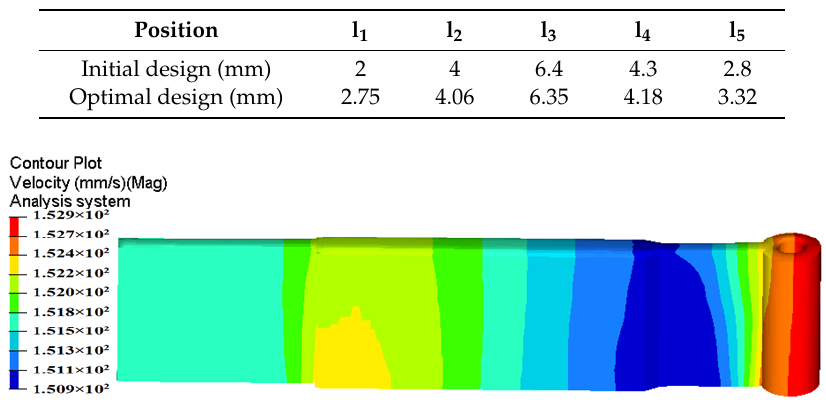
Figure 14. Uneven bearing lengths in the profile (mm). Table 4. Bearing lengths for the initial and optimal dies.